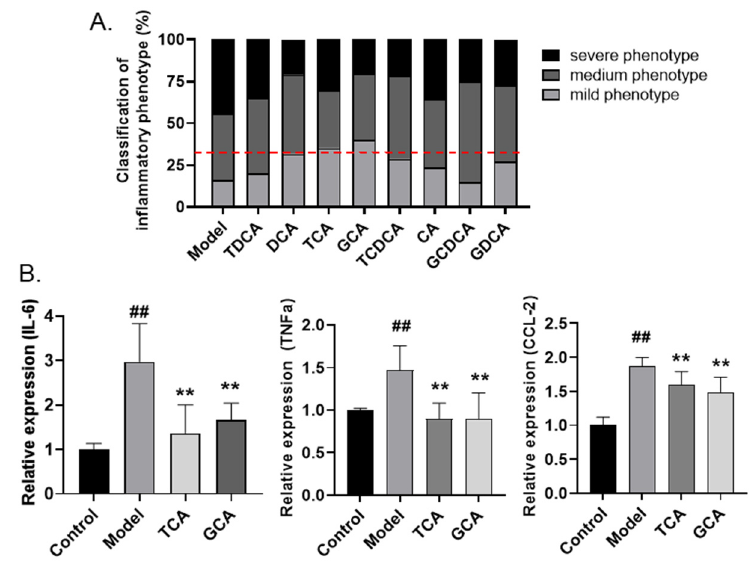
Figure 4. Screening active compounds of bile acids in zebrafish model. ( A ) The classification of inflammatory phenotypes in zebrafish embryos treated with different bile acids (n > 10). The cutoff line for positive hits is shown in red dotted line. ( B ) The mRNA levels of IL-6, TNF- α , and CCL-2 in zebrafish embryos of different groups (n > 10). Data are presented as the mean ± SEM of three independent experiments. # Compared with the control group; * compared with the model group; ## or **, p < 0.01.